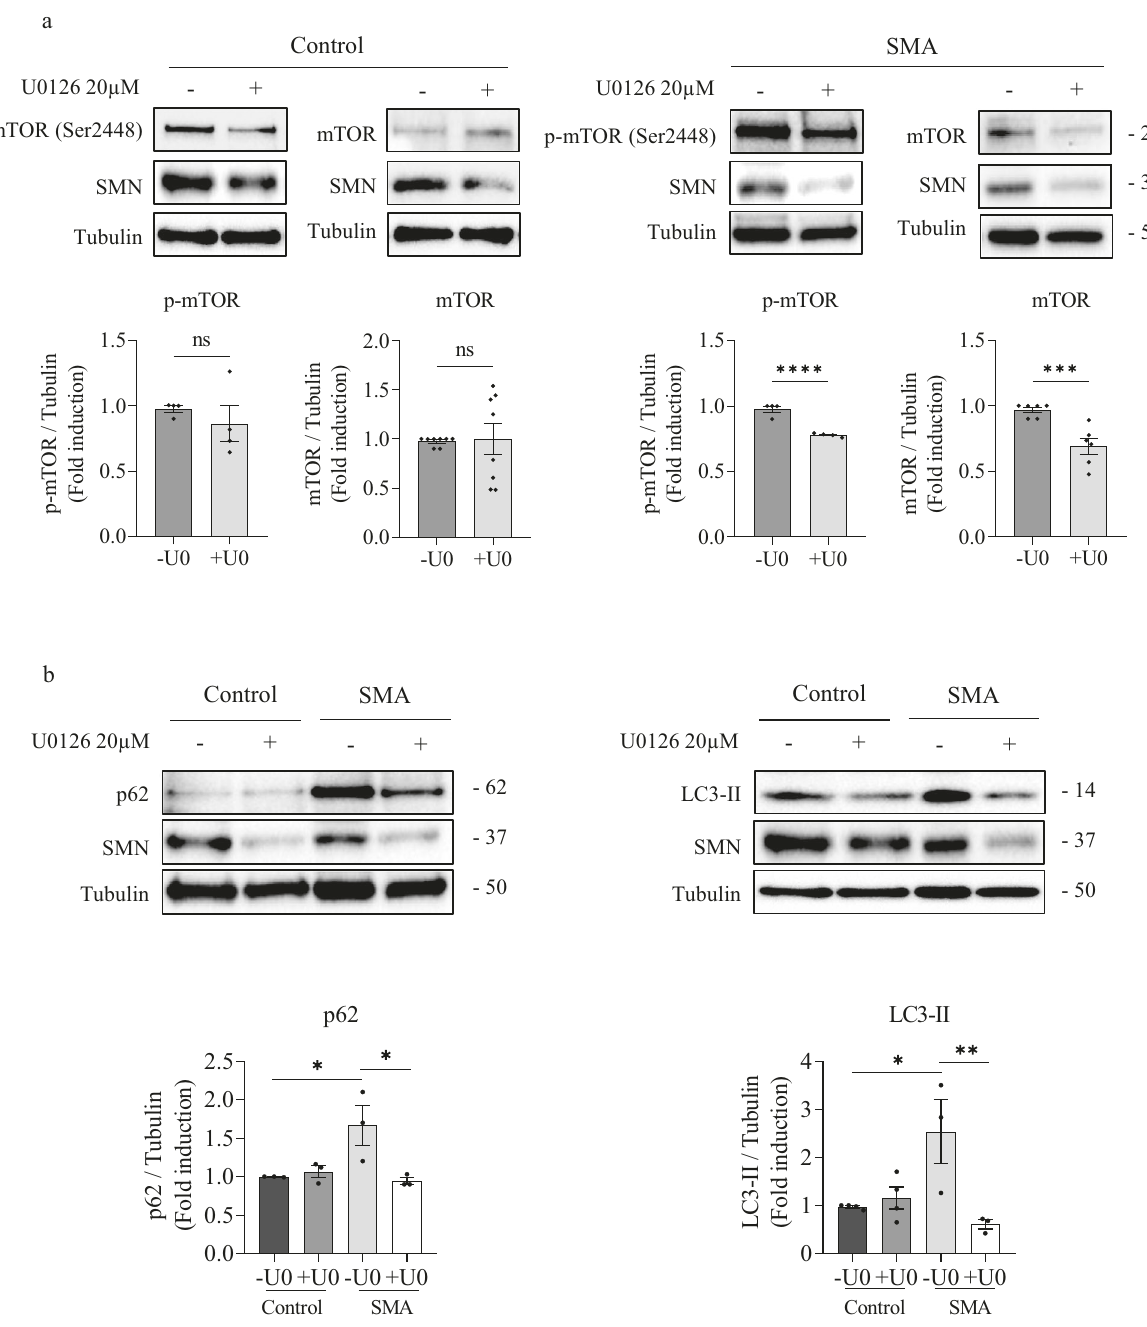
Fig. 4 ERK MAPK inhibition regulates mTOR phosphorylation and autophagy markers in human SMA MN. a , b Seven-day differentiated Control and SMA human MNs were treated with 20 μ M U0126 (U0) during 24 h or left untreated. Cell lysates were then obtained and submitted to western blot analysis using anti-phospho-mTOR (p-mTOR Ser2448), anti-mTOR, anti-p62, anti-SMN, or anti-LC3 antibodies. Membranes were reprobed with anti- α -tubulin antibody ( a , b ). Graphs represent the expression of p-mTOR or mTOR vs α -tubulin ( a ), and the expression of p62 or LC3-II vs α -tubulin ( b ), corresponding to the quanti fi cation of at least 3 independent iPSCs differentiation cycles ± SEM. Asterisks indicate differences using Student t -test (* p < 0.05; *** p < 0.001; **** p < 0.0001; ns no signi fi cant differences p >